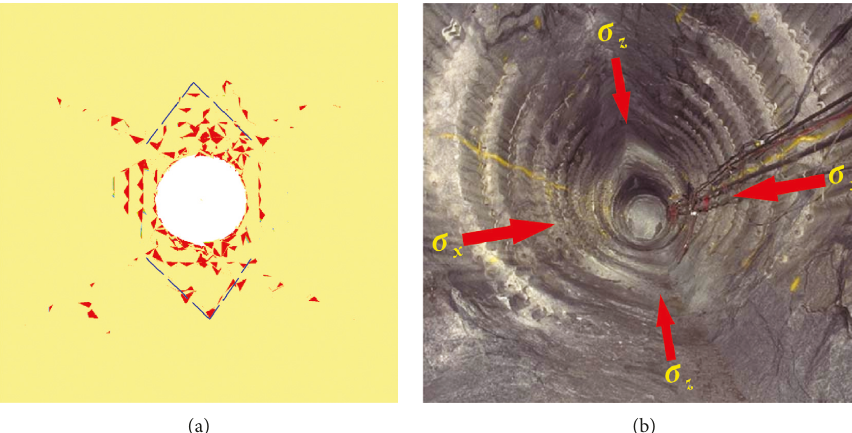
Figure 11: Fracture distribution around the roadway boundary when the horizontal stress is maximum principal stress: (a) numerical result; (b) field observation result